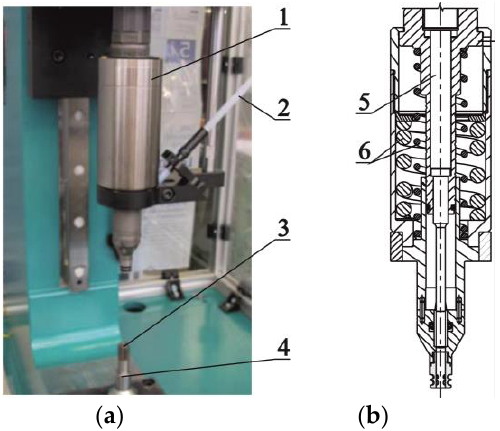
Figure 3. Forming tools used in the CR joining process: ( a ) punching system with rivet feeding system, ( b ) spring system integrated with punching system (1-frame, 2-rivet feeding tube, 3-die with movable segments, 4-die holder, 5-punch, 6-spring system).